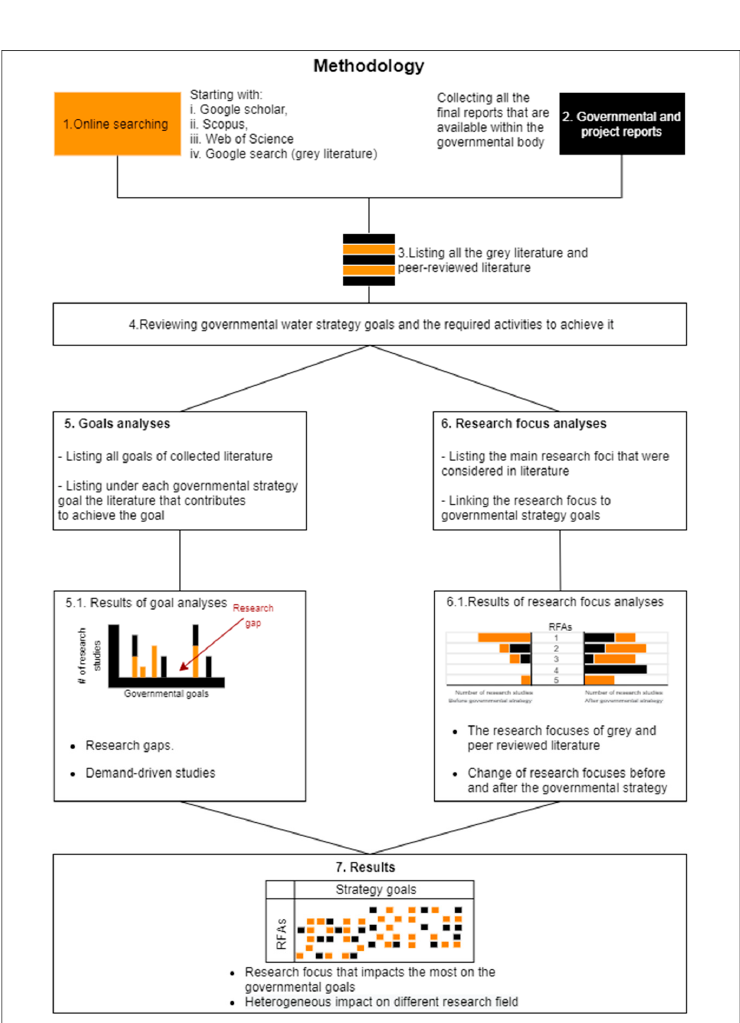
Figure 2. Schematic figure for the methodology we followed in this paper .